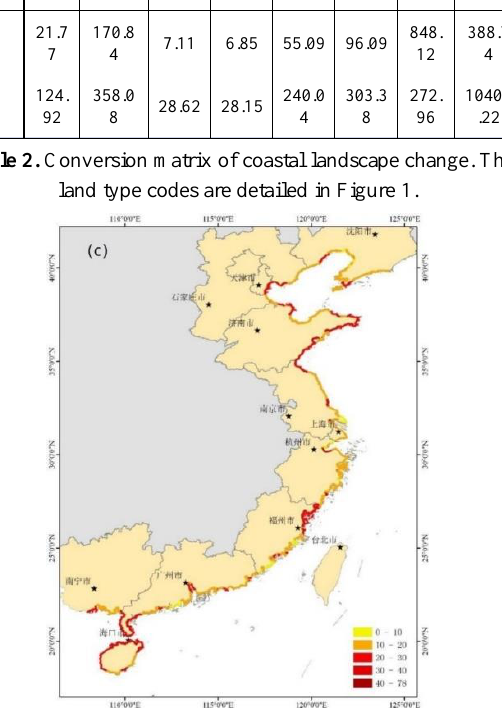
Figure 8 . Importance degree of landscape transformation from natural landscape to artificial landscape at the county scale from 2015 to 2019. Figure 9 indicates the national provincial development and